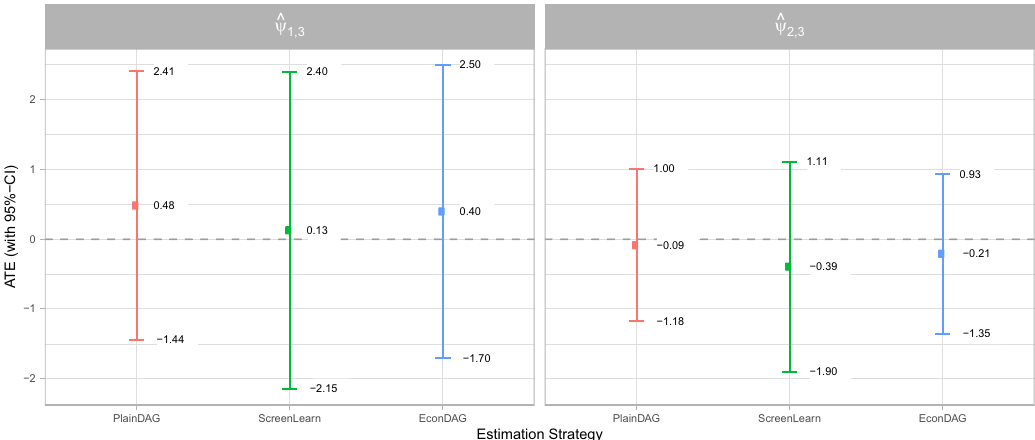
Figure 9: ATE among the high - income countries ( n 26 = ) .